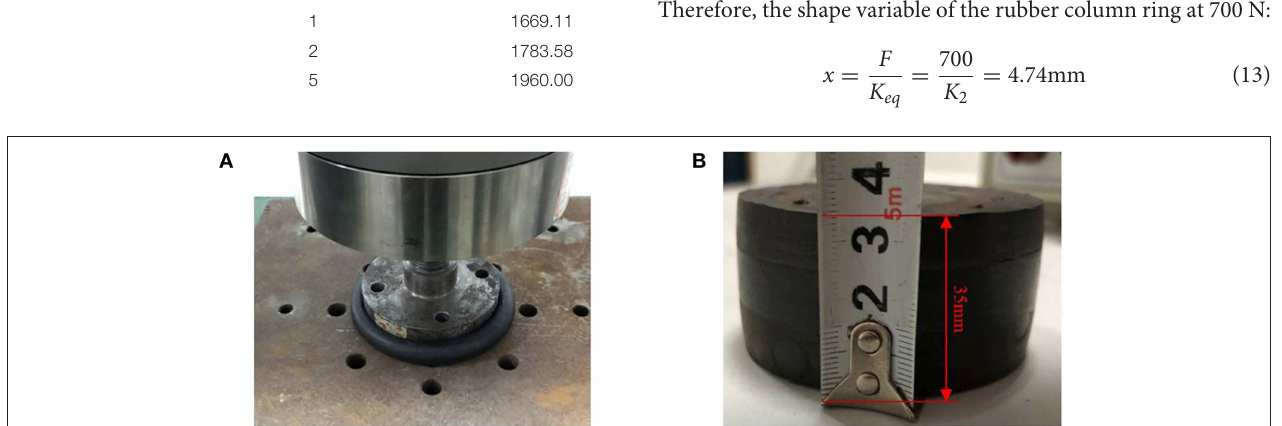
Frontiers in Materials |